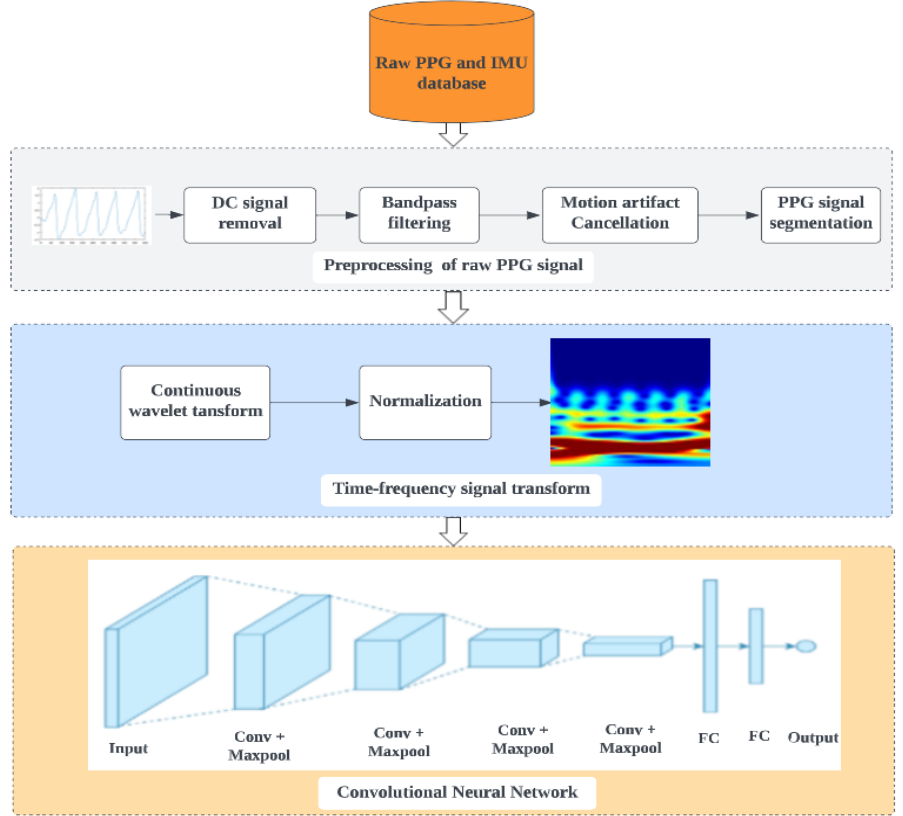
Figure 4. Overall block diagram of the proposed system for mental stress detection.